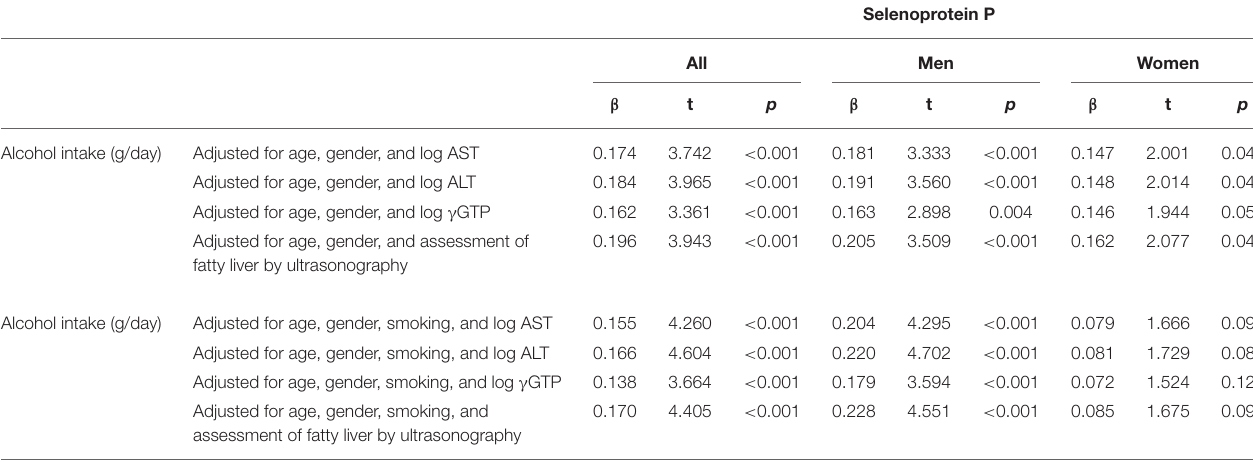
TABLE 3b | Relationship between alcohol intake and selenoprotein P inparticipants taking